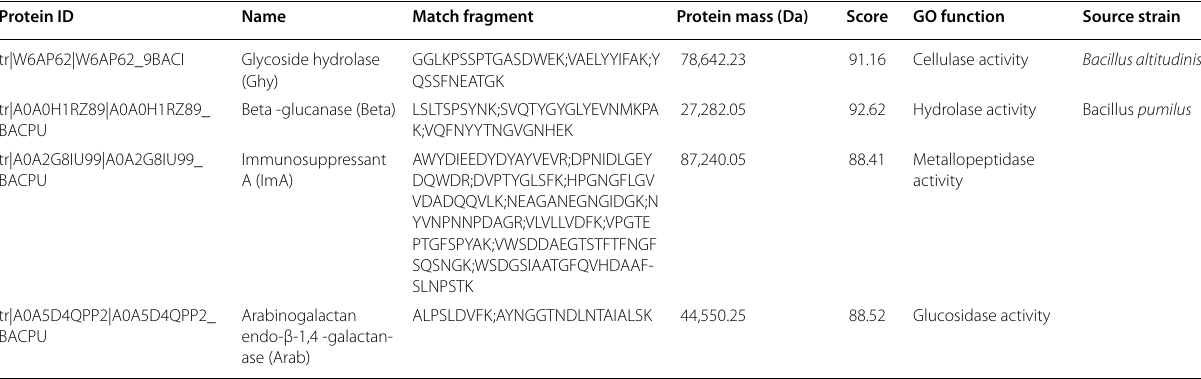
Table 7 The peptide fragments antagonistic protein of B. pumilus HR10 obtained by LC–MS‑MS Protein